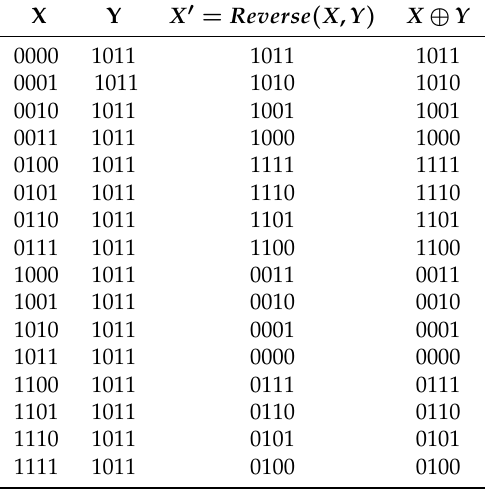
Table 2. The truth table to show the equality of X (cid:48) = Reverse ( X , Y ) with X ⊕ Y